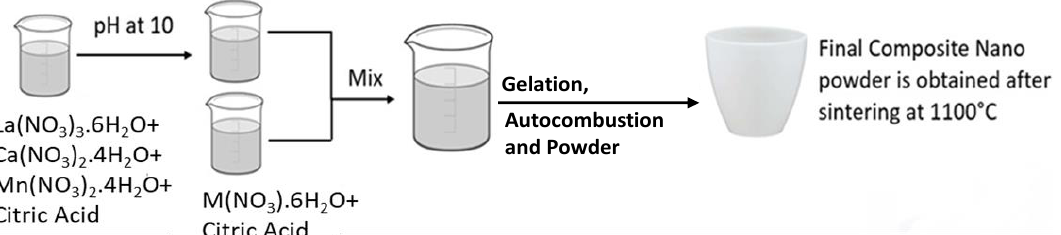
Figure 1. Schematic of preparation of LCMO-MO composite powder.